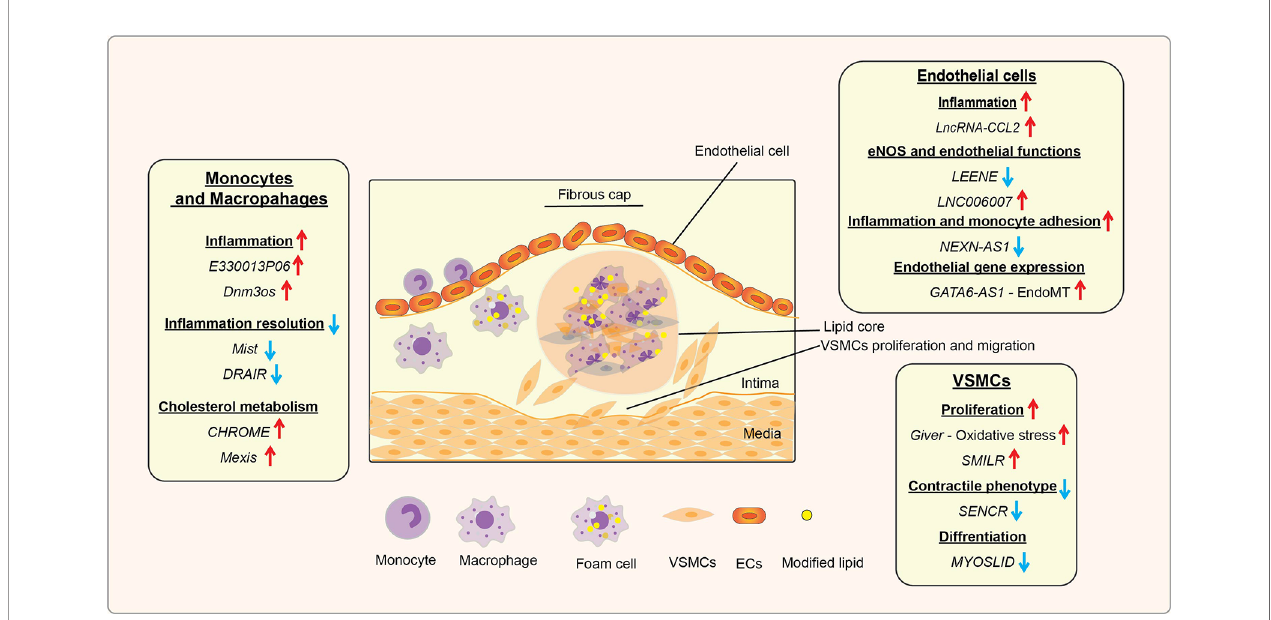
FIGURE 3 | Role of lncRNAs in in fl ammatory processes and diabetic cardiovascular complications. A schematic showing the roles of candidate lncRNAs with functions in endothelial cells (ECs), monocytes and macrophages, and vascular smooth muscle cells (VSMCs) during the initiation and progression of in fl ammatory CVDs, such as atherosclerosis, that are enhanced in diabetes. The reported roles of lncRNAs in processes related to atherosclerosis and related CVDs are indicated under relevant cell types (monocytes/macrophages, ECs, and VSMC). Arrows indicate the direction of changes in the expression or function. CVDs, Cardiovascular diseases; EndoMT, Endothelial to mesenchymal